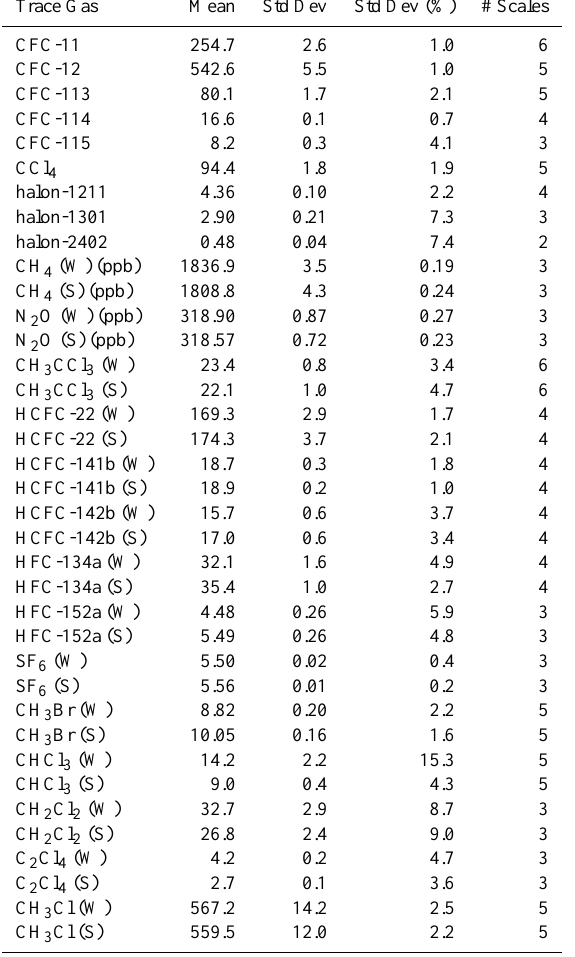
Table 5. Analysis statistics for undiluted samples based on results from laboratories that develop calibration scales. Results from lab- oratories that adopt scales are not included here because we do not want to introduce potential scale transfer errors. Gases with large differences between winter (W) and summer (S) fillings were treated separately. All mole fractions are pmolmol − 1 (ppt) unless